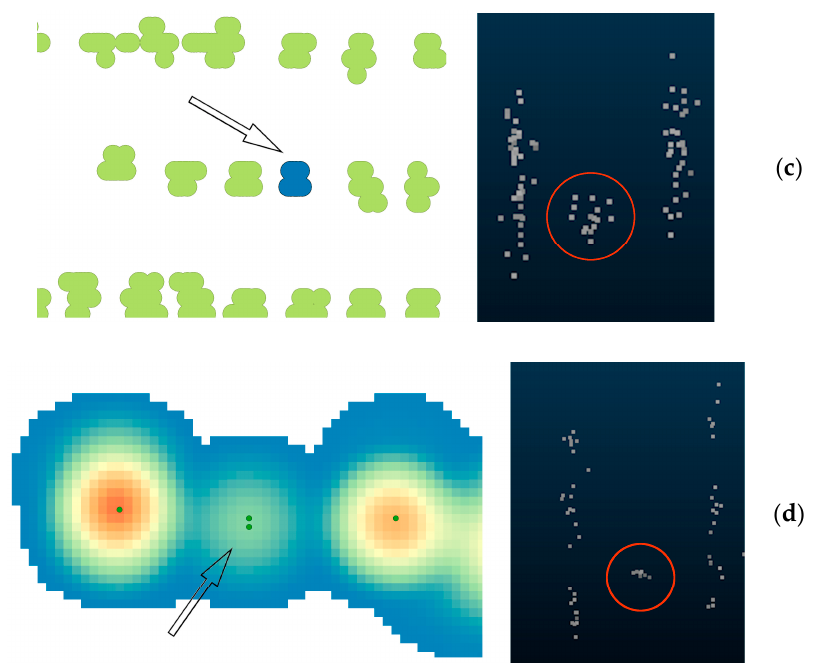
Figure 8. Examples of points that derived into commission errors: ( a ) and ( b ) are examples regarding canopy returns; ( c ) and ( d ) are examples regarding snag trees.